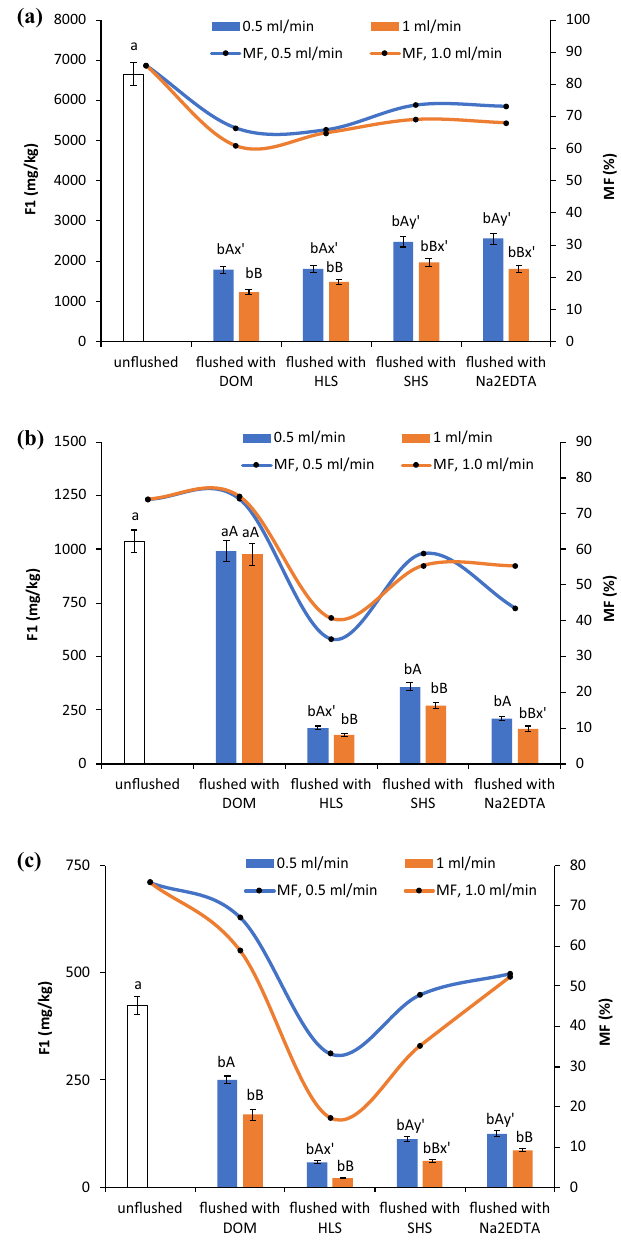
Figure 2. Changes in the content of the exchangeable and acid soluble fraction (F1) and the mobility factor (MF) of HMs in soil before and after flushing with DOM, HLS, SHS and Na 2 EDTA: ( a ) Cu, ( b ) Pb, ( c ) Zn. Small letters (ab) indicate statistically significant differences in the content of the F1 fraction between the unflushed and flushed soils, capital letters (AB) indicate significant differences in the content of the F1 fraction between the flow rates with one WA. The symbols x’ or y’ indicate no statistically significant differences between some